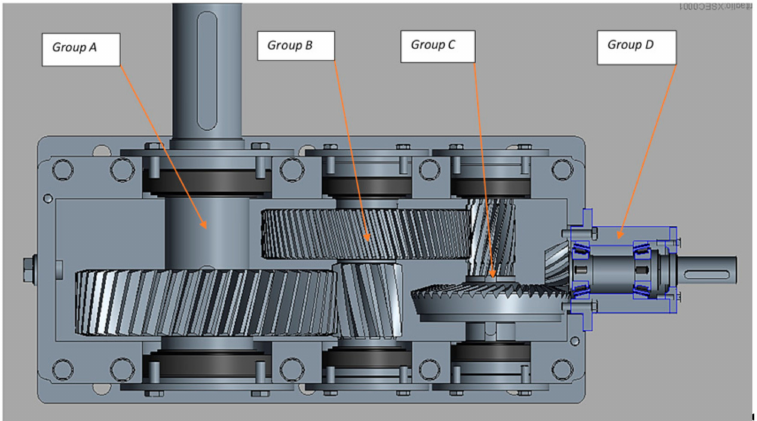
Figure 4. The four sub-groups of the